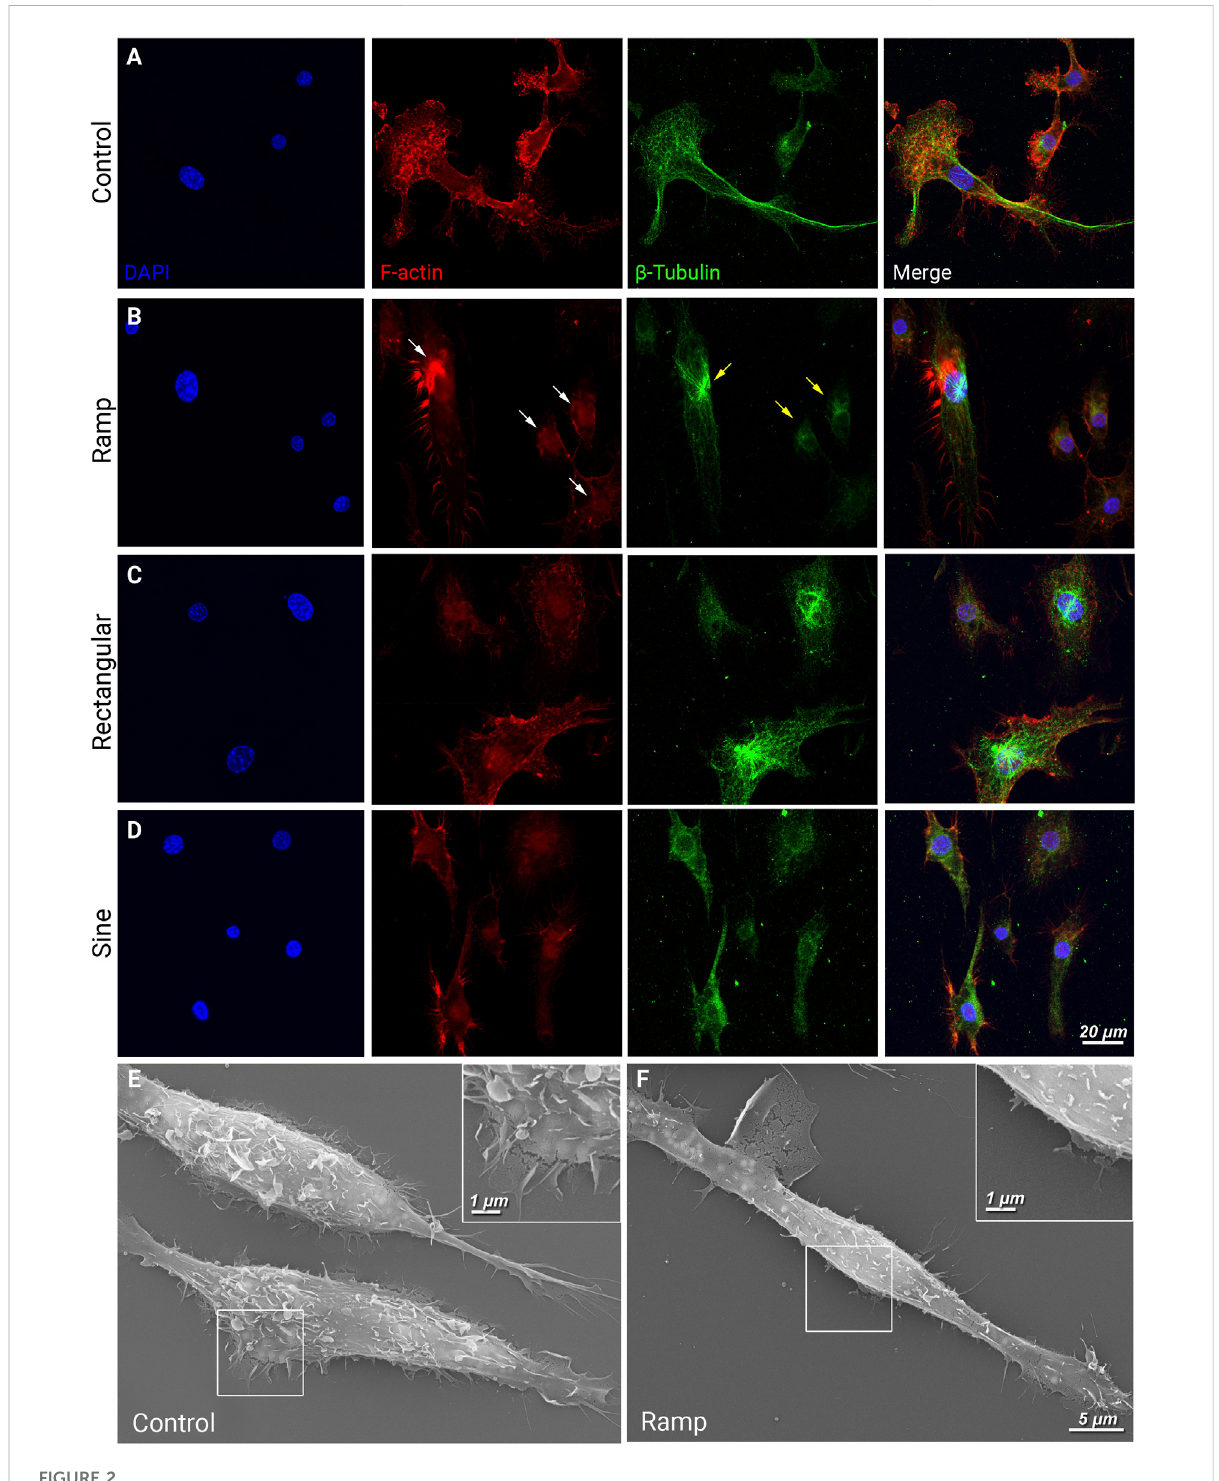
FIGURE 2 Ramp ES inhibits the redistribution of cytoskeletal and motility proteins and the formation of cellular lamellipodia and microvilli. (A – D) Immunostaining of F-actin (red) and β -tubulin (green) in BV-2 cells cultured under a control condition (A) after ES biphasic ramp; white arrow indicates redistribution of F-actin within the cell. (B) , ES biphasic rectangular (C) , or ES biphasic sine (D) . Scale bar: 20 µm. (E,F) Scanning electron microscopy images ofBV-2cellsincontrol (E) andafter ESbiphasicramp (F) .Insertsreveal cellmembranemorphology intheleadingedgeand lamellipodia. Scale bar: 5 μ m; insert: 1